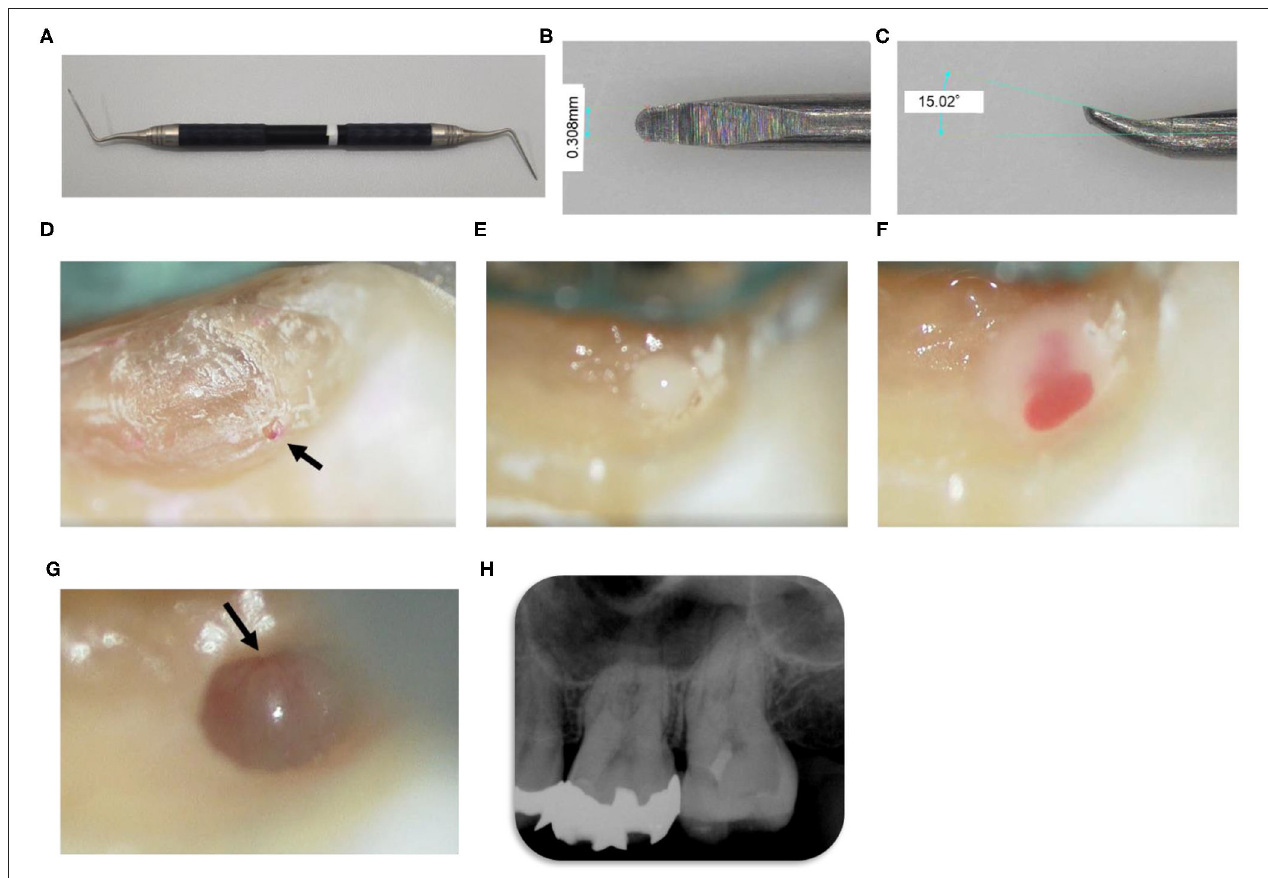
FIGURE 2 | Clinical images extracted from video recording during the first visit. Videos are available online at doi: 10.6084/m9.figshare.13228427 as Supplemental Materials. (A) A custom microextractor. (B) Enlarged image highlighting the size and scale of the microextractor. (C) Enlarged image showing the angle to axis of microextractor. (D) Microscopic image immediately after removal of infected dentin without magnification. The dental operating microscopy demonstrated areas of “spot staining” with caries detection fluid (black arrow). (E,F) Pus overflowed from the exposed pulp tissue and the area bled profusely. (G) After debridement, pulp tissue with vascular-like structures was observed (black arrow). (H) Radiographic images after pulpotomy